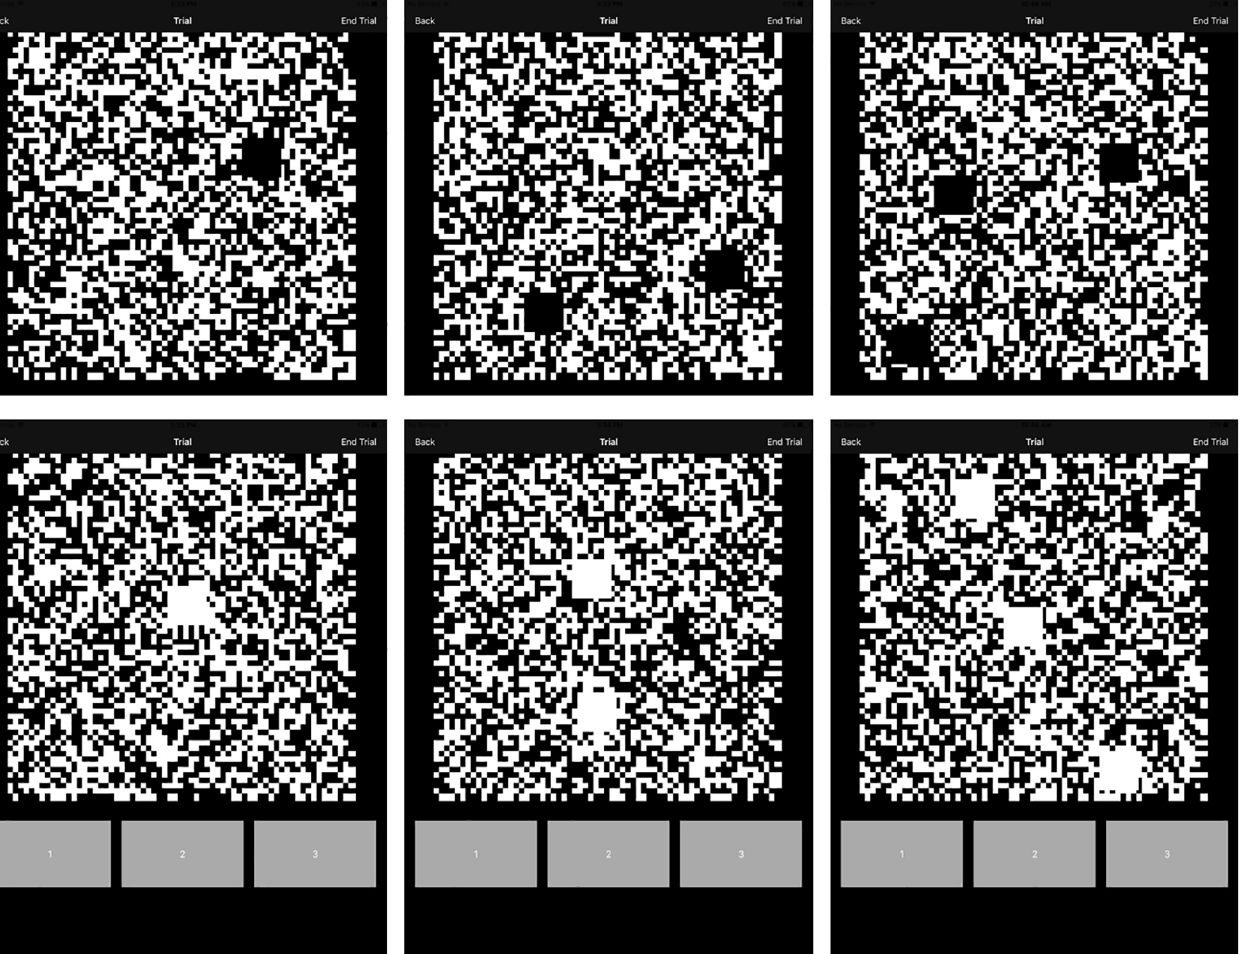
Fig 1. The display screen of the “EyeSpeed” app during the test. The top panels show dark targets in a noise background and the bottom panels show the light targets. The option to choose the correct answer is shown in grey boxes. The number choices are presented in ascending order. Grey option boxes were also present for the top panels as well during the test, which has been removed in this representation for compact viewing.